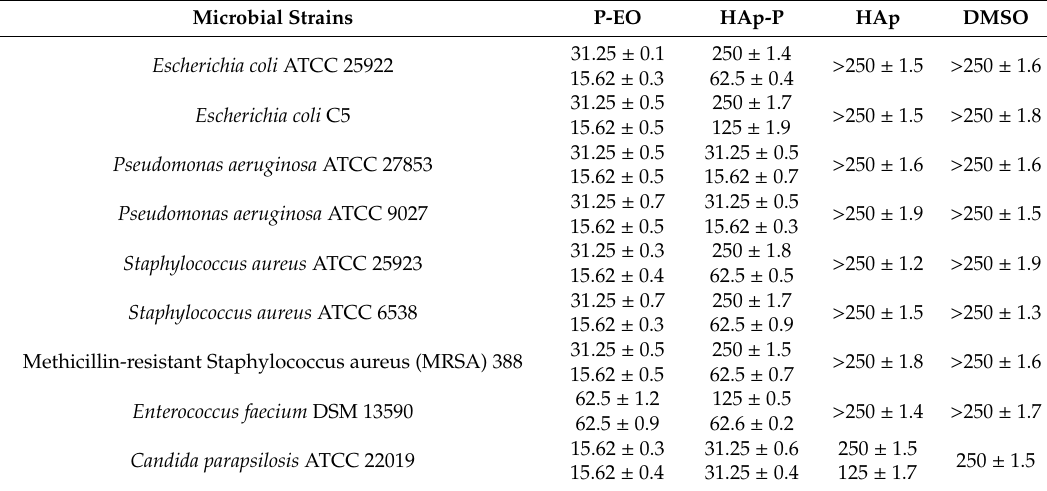
Table 2. Minimum inhibitory concentration (MIC) and minimum bactericidal concentration (MBC) values obtained for DMSO, HAp, P-EO and